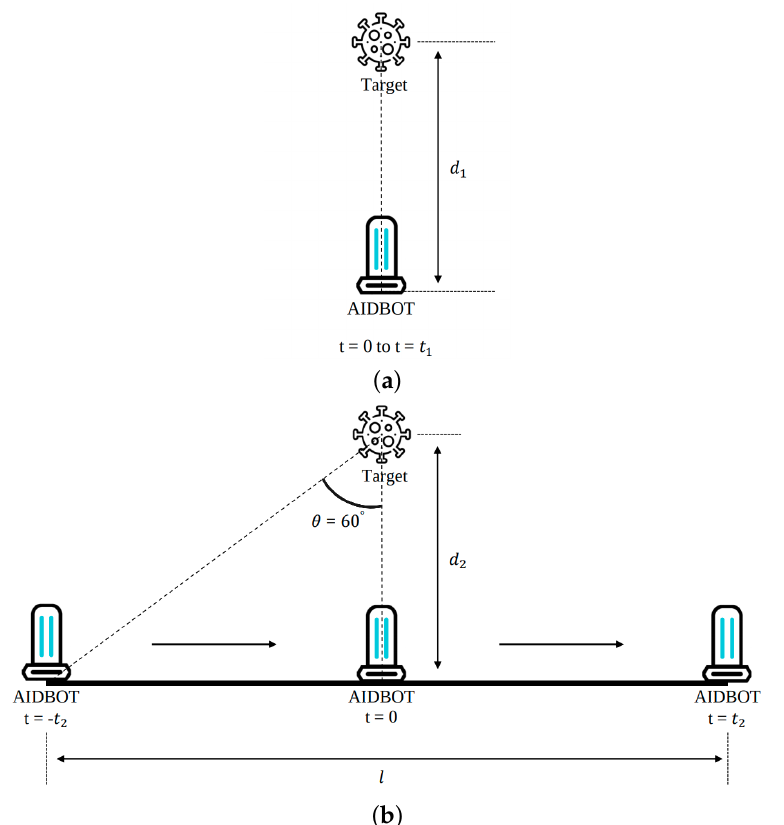
Figure 3. Illustration of two disinfection experiments with the UVD robot ( a ) Without moving, the UVD robot disinfects a target d 1 meters away for t 1 seconds. ( b ) At a velocity of v 2 , the UVD robot disinfects a target d 2 meters away for t 2 seconds ( d 2 : vertical distance between the target and the UVD robot’s